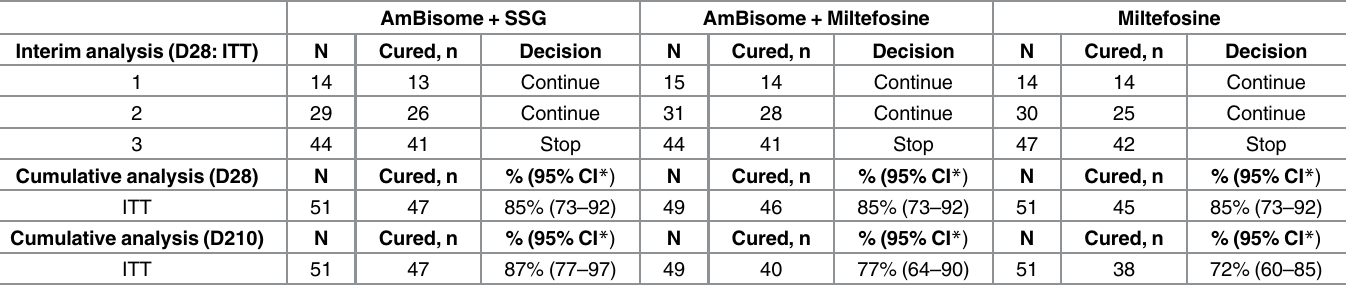
Table 5. Outcomes and events during treatment: